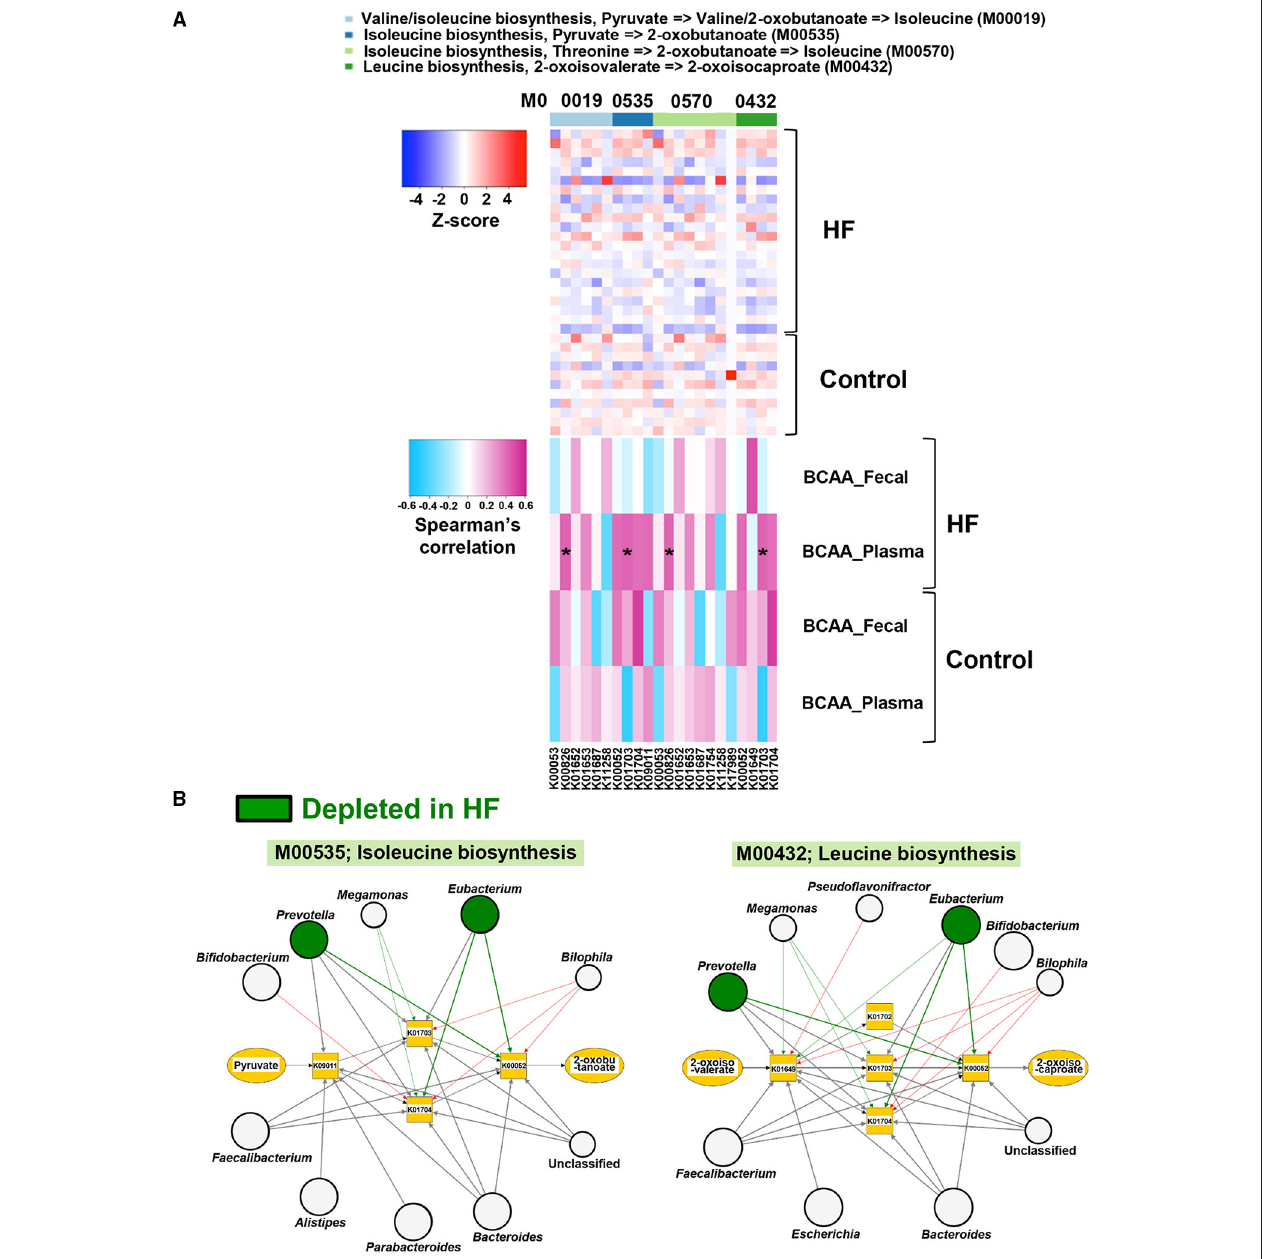
FIGURE 5 | Correlations of gut microbial functions with host plasma and fecal branched chain amino acid (BCAA) concentrations along with the visualization of genera associated with BCAA biosynthesis. (A) Correlations of abundances of genes involved in BCAA biosynthesis with plasma and fecal BCAA concentrations in heart failure (HF) patients ( n 22) and controls ( n 11). (B) Kyoto Encyclopedia of Genes and Genomes (KEGG) orthology (KO) genes and their associated genera in = = BCAA biosynthesis (M00535 and M00432) are shown. The genera depleted in patients with HF ( n 22) are indicated by green circles. Arrows are drawn from the top = 5 abundant genera in each KO gene (thick arrows) or from the genera with differentially enriched KO genes between patients with HF ( n 22) and controls ( n 11). = = Red arrows indicate that the KO genes possessed by each genus were significantly increased in patients with HF ( n 22). Green arrows indicate the KO genes = significantly decreased in patients with HF ( n 22). Large circles indicate the top 10 abundant genera (i.e., Bacteroides , Prevotella , Subdoligranulum , Eubacterium , = Escherichia , Streptococcus , Bifidobacterium , Faecalibacterium , Alistipes , and Parabacteroides ) in all samples ( n 33). * P < 0.05. =